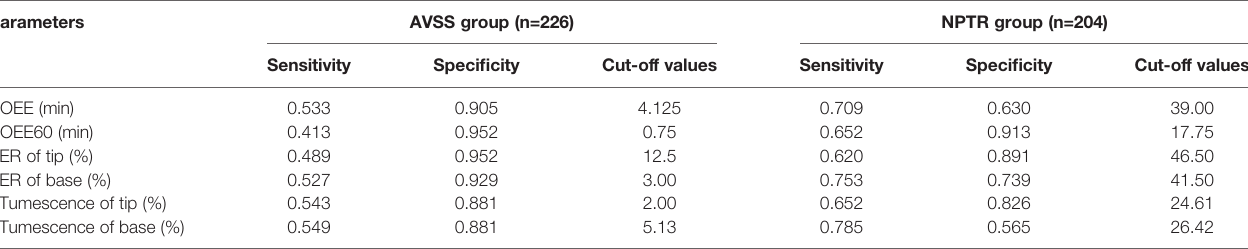
TABLE 3 | Optimal cut-off values between AVSS group and NPTR group in tadala fi l responders prediction. Parameters